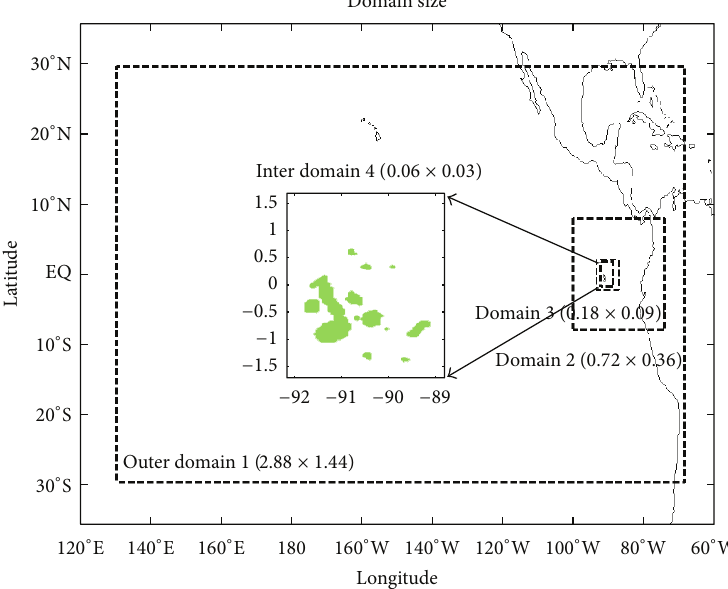
Figure 2: Model domain size of the outer domain (with the resolution 2.88 ∘ × 1.44 ∘ ), the intermediate domains (covering the Eastern Pacific Ocean, with the resolutions of 0.72 ∘ × 0.36 ∘ and 0.18 ∘ × 0.09 ∘ ), and the inter domain with the highest resolution of 0.06 ∘ × 0.03 ∘ .